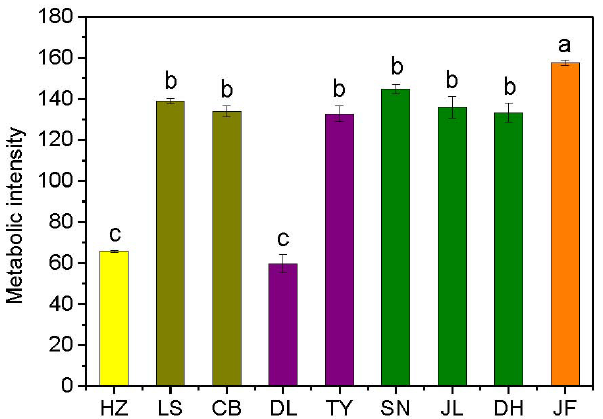
Figure 2. Variations in soil microbial substrate use during a 240h incubation for the nine forests. Different colors represent differ- ent forest types: yellow, coniferous forest; dark yellow, coniferous broad-leaved mixed forest; purple, deciduous broad-leaved forest; olive, subtropical evergreen broad-leaved forest; and orange, tropi- cal monsoon forest. Different lowercase letters indicate significant differences among forests in the same climate zone. The abbrevia- tions of the sampling sites are given in Table